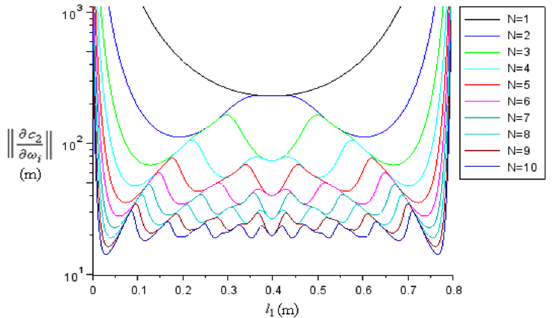
Figure 12. The graph of (22) (log scale) for different numbers of resonances N , with constant c 2 and l 2 . l 2 = l 4 = 18.16 mm and l 1 + l 3 + l 5 = 795.5 mm fixed. The norm (22) was minimized